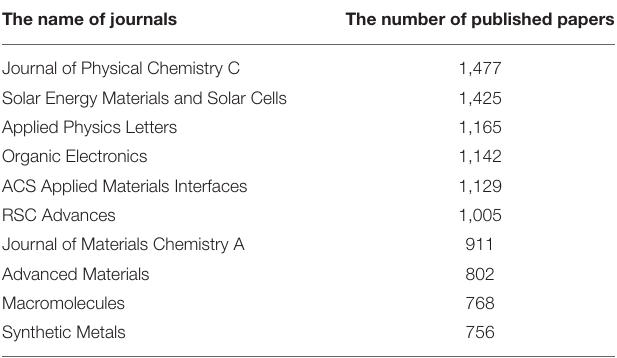
TABLE 1 | The top 10 most productive